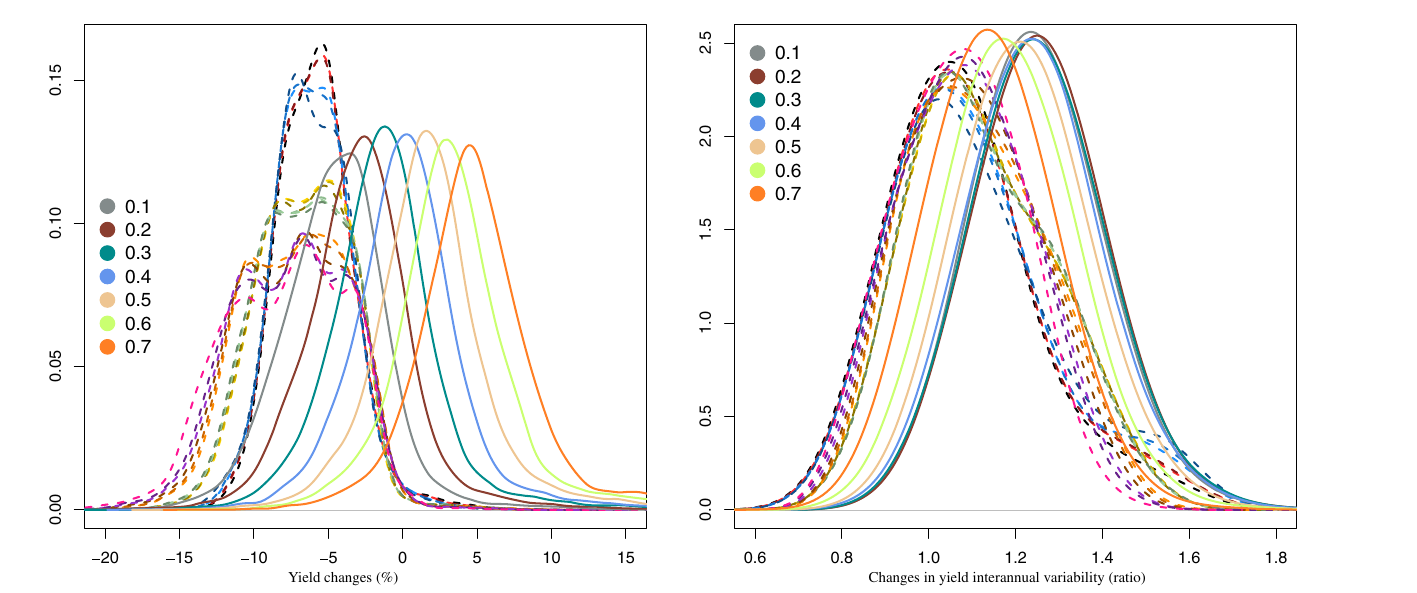
Fig. 4 Effects of the idealised climate service on mean yield changes. Spatial probability density functions of the ensemble mean yield changes (%; 2021 – 2040 vs 1986 – 2005) estimated for each ideotype (dotted line) and for the simulations integrating the idealised climate service with different levels of skill (bold lines and according to the colours from 10% to 70%).